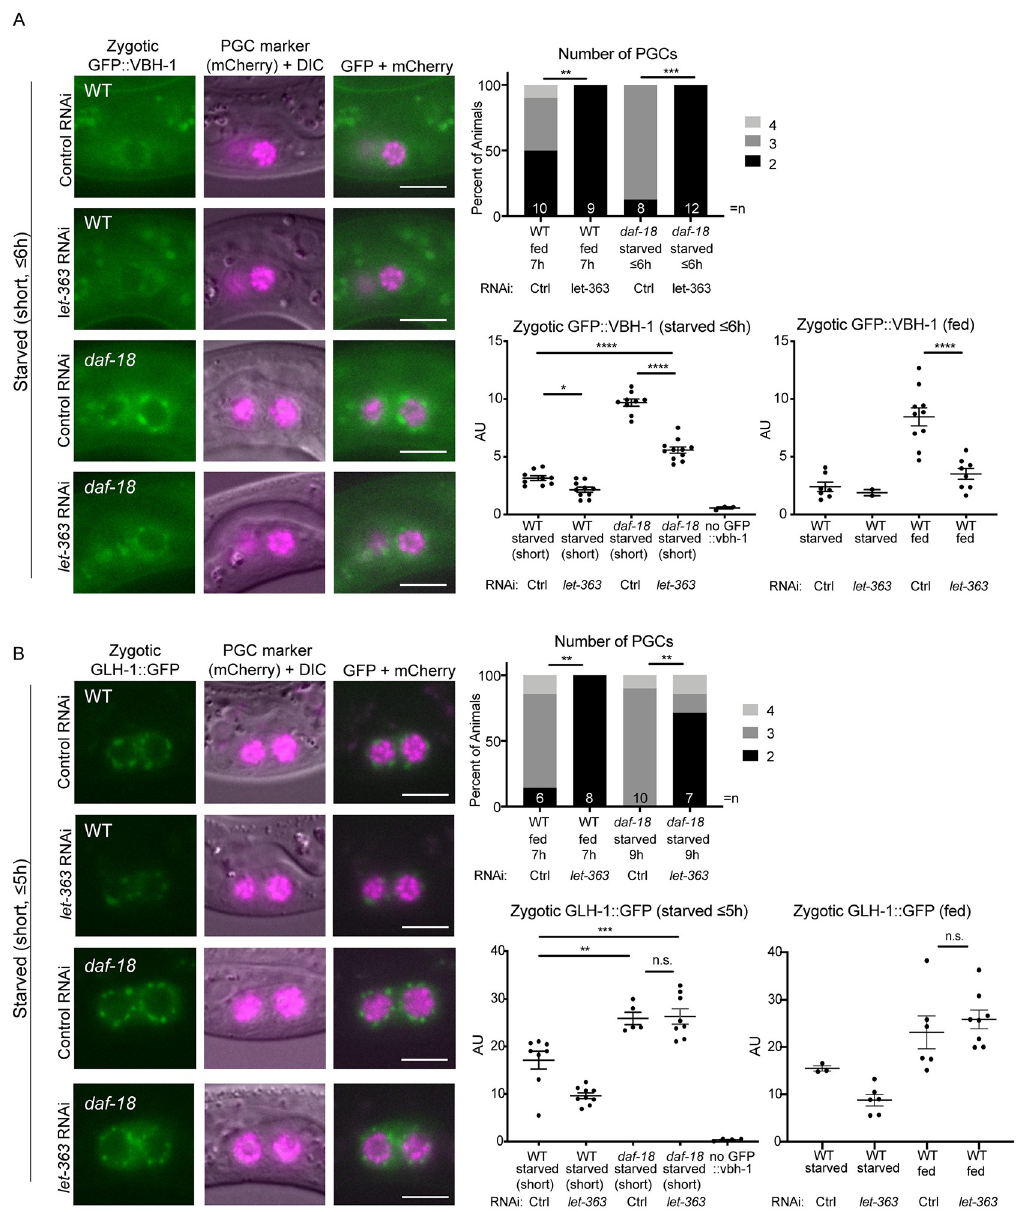
Fig 6. Regulation of germline zygotic gene expression by DAF-18 is partially independent of TOR. (A-B) Crosses were performed as in Fig 4, but on RNAi bacteria (RNAi by feeding), and L1 progeny analyzed, either starved (images and graph) or fed (graph only). RNAi bacteria carried dsRNA to let-363 /TOR or Control (“Ctrl”; empty vector L4440). Images show epifluorescence. Plotted to the right of each set of images are 1) plots of PGC numbers to illustrate efficacy of let-363 /TOR RNAi in that experiment, and 2) graphs of mean perinuclear GFP fluorescence intensity (AU) values for starved or 3) fed L1 progeny. For PGC number graphs, statistical significance determined by Fisher’s exact test (two-sided). �� p < 0.01, ��� p < 0.001. For zygotic GFP images, exposure time is longer for GFP::VBH-1 than GLH-1::GFP. For GFP quantification graphs, each dot represents one animal (either average of 2 PGC values, or one PGC per animal). Non-cross progeny were identified by the lack of somatic GFP (“no GFP::vbh-1”) or lack of any GFP P-granules (“no GLH-1::GFP”; this transgene is much brighter and is clearly visible in starved WT PGCs). Mean +/- SEM. Statistical significance determined by one-way ANOVA (Tukey’s multiple comparisons test). � p < 0.05, �� p < 0.01, ��� p < 0.001, ���� p < 0.0001. All scale bars represent 10 μ m. For these experiments, the exact timing of image analysis is as follows (see Methods): “Starved (short)” L1 progeny were imaged up to 6 hours after hatching. “Starved” and “fed” L1 progeny were imaged up to 22 hours after clean embryo preparation; the last 7 hours of which for “fed” were on food. For (A), two additional replicates showed similar results (slight suppression of elevated GFP::VBH-1 in daf-18 mutants, by TOR RNAi). To assess let-363 /TOR RNAi efficacy, PGC numbers were counted in L1s starved up to 6 hours. For (B), one additional replicate showed similar results (no suppression of elevated GLH-1::GFP in daf-18 mutants, by TOR RNAi), and PGC numbers were counted in L1s starved up to 9